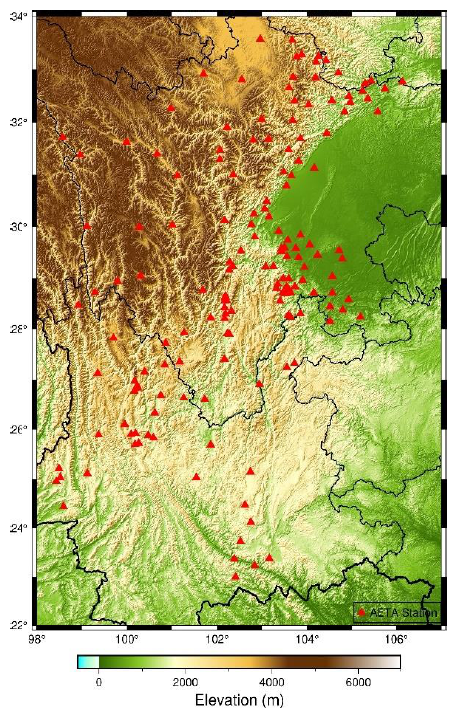
Figure 2. AETA stations located in Sichuan – Yunnan area.